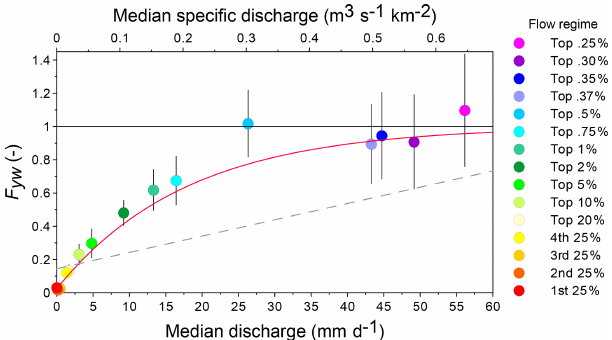
Figure 1. Variation in time-weighted young water fraction at the Can Vila catchment with increasing quantiles of the flow duration curve. The dashed grey line represents Eq. (5) and the red curve represents Eq. (6), using parameters obtained by fitting Eqs. (4) and (8), respectively, to all the stream water δ 18 O isotope values. Dis- charge values are instantaneous measurements expressed in daily units. Maximum sampled discharge was 226mmd − 1 . Vertical bars represent standard